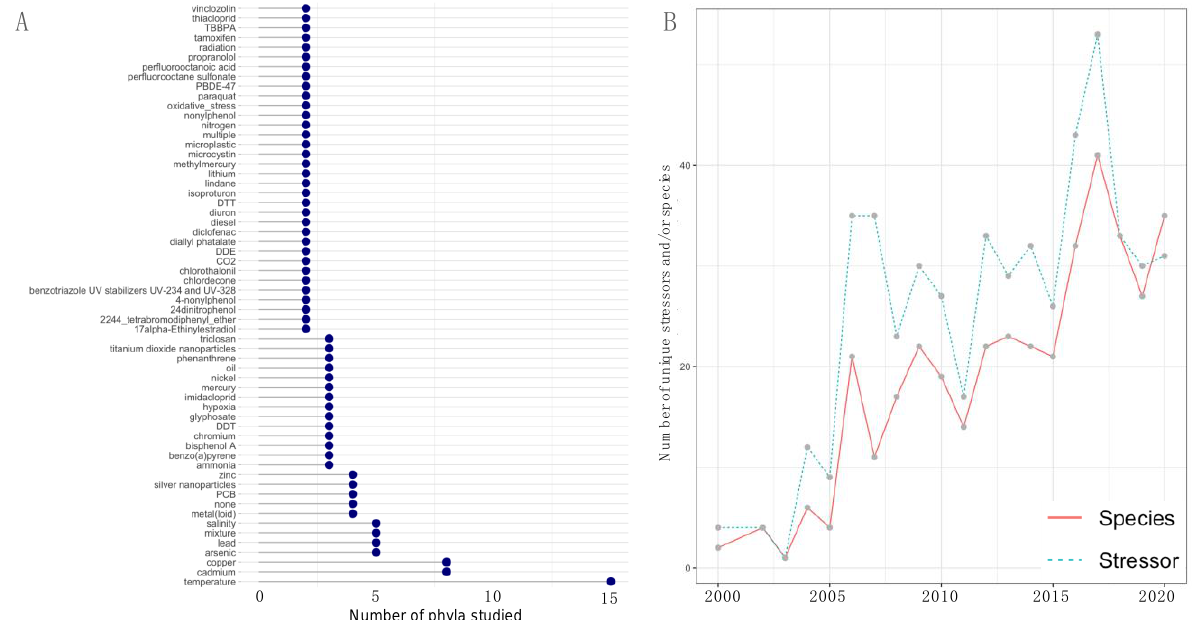
Figure 3. Overview of stressors, phyla and species investigated using omics methods from 2000 to 2020. ( A ) Number of phyla studied for unique stressors (only stressors for which more than one phylum has been investigated are shown). ( B ) Line plot showing the number of unique stressors and species studied each year.